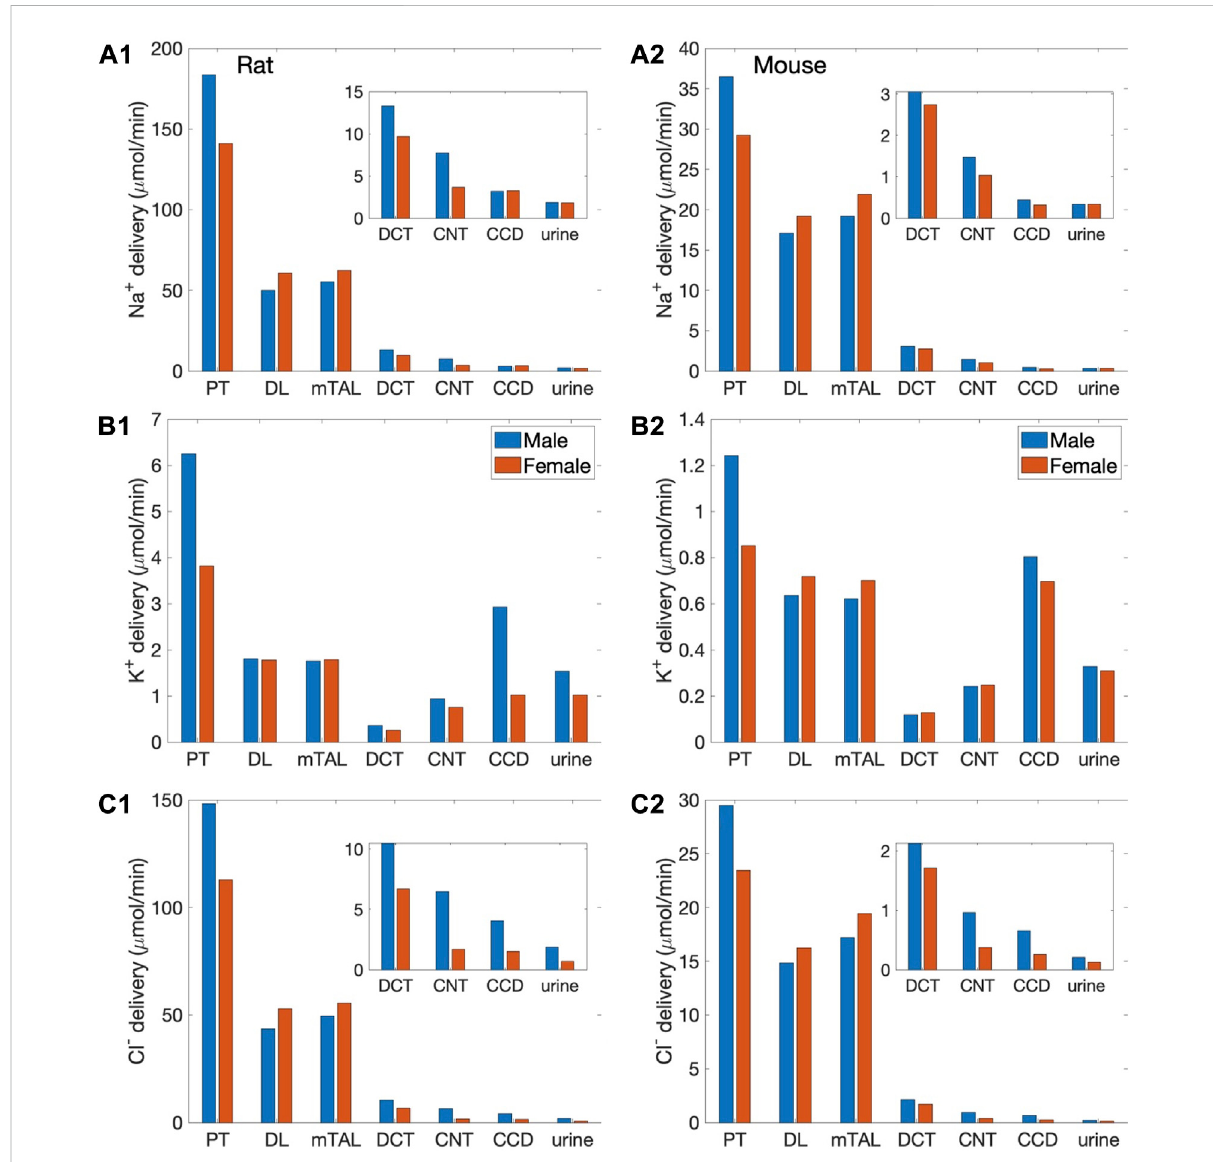
Delivery of key solutes and fl uid to the beginning of individual nephron segments in male and female rats (A1 , B1 , C1 , D1 , E1 , F1) and mice (A2 , B2 , C2 , D2 , E2 , F2) . Flows along super fi cial and juxtamedullary are scaled by their population and added together. The rightmost sets of bars show urine excretion rates. PT, proximal tubule; DL, descending limb; mTAL, medullary thick ascending limb; DCT, distal convoluted tubule; CNT, connecting tubule; CCD, cortical collecting duct. Insets: magni fi ed reproductions of distal segment values. The difference between in fl ow of consecutive segments corresponds to net transport along that segment. Notably proximal tubules mediate signi fi cantly more solute and water transport in rats than mice; and within each species, more in males than